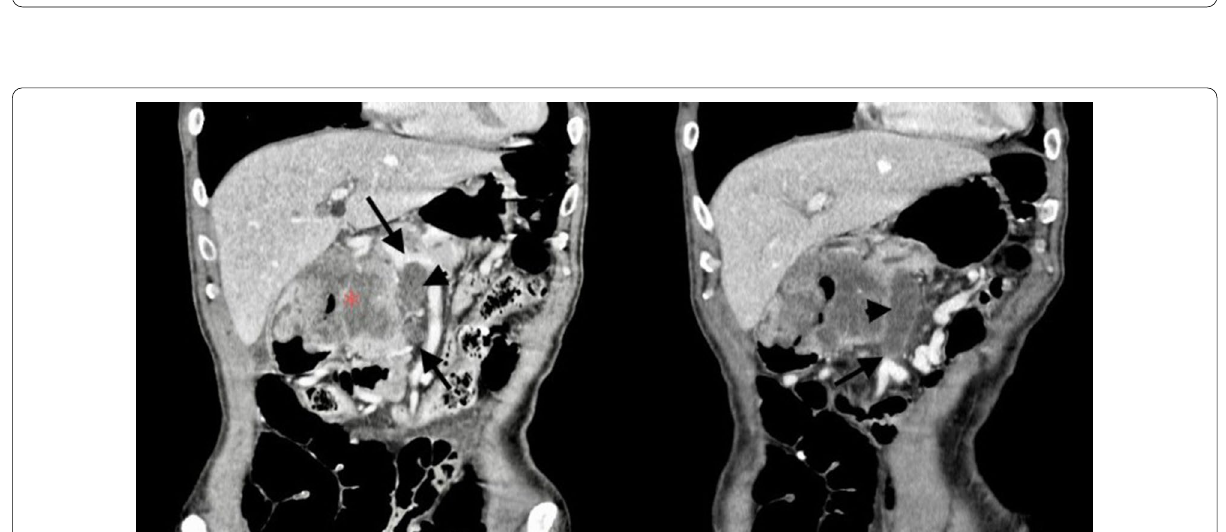
Fig. 2 Abdominal enhanced CT. Approximately 10 cm tumor with poor contrast effect was observed in the pancreatic head area (*). A tumor thrombus (arrowhead) of about 6 cm was observed from the superior mesenteric vein (up arrow) to the junction of the portal splenic vein (down